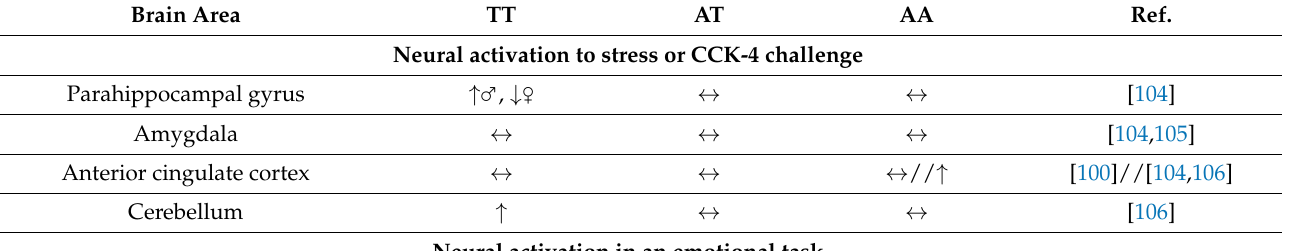
Table 5. Summary of the clinical studies showing the impact of the SNP rs324981 on neural activation in various tasks in healthy